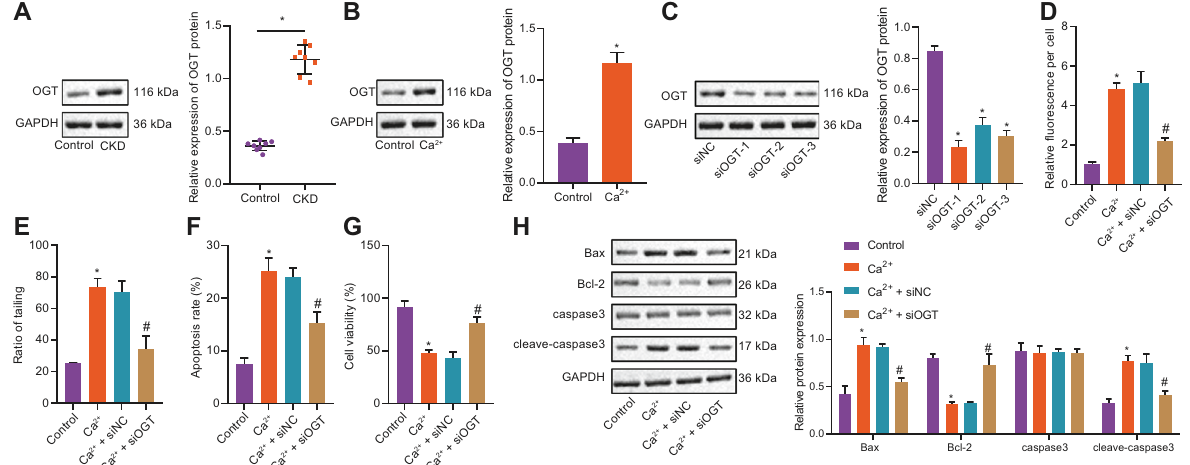
Fig. 2 Silencing OGT reduces the toxicity of primary neurons induced by hypercalcemia. A Western blot analysis was used to detect the expression of OGT in brain tissues of mice in each group (n = 8). * p < 0.05. vs . the control group (mice on a standard diet). B Expression of OGT in neurons induced by hypercalcemia. * p < 0.05. vs. the control group (neurons cultured in basic medium). C Western blot analysis was used to detect the interference ef fi ciency of three OGT interference sequences. * p < 0.05. vs. the si-NC group (neurons treated with si-NC). D luo-4-am, and Perkin Elmer Operetta were used to measure the intracellular calcium level. E Comet assay was used to observe the DNA damage of each group. F Flow cytometry was used to detect apoptosis. G MTS assay was used to detect the neuronal viability. H Western blot analysis was used to detect the expression of apoptosis-related proteins. * p < 0.05. vs. the control group (neurons cultured in basic medium). # p < 0.05. vs. the Ca 2 + + si-NC group (neurons treated with Ca 2 + + si-NC). The experiment was repeated 3 times independently. than that in the control group (Fig. 2A). After that, we primarily memory abilities of CKD mice were worse (Fig. 1E). Compared with cultured mouse neurons, and the neurons were induced to the control group, the content of calcium in brain tissues of CKD produce hypercalcemia by using a high calcium concentration mice was increased (Fig. 1F). TUNEL staining results showed that medium. The results showed that the expression of OGT in mouse compared with the control group, CKD mice had more neuronal apoptosis (Fig. 1G). The above results indicate that calcium content in brain tissues of CKD model mice is increased and nerve function is obviously damaged. OGT is highly expressed in kidney tissues of CKD model mice. Silencing OGT reduced the toxicity of primary neurons induced by hypercalcemia It has been con fi rmed that OGT is expressed in the kidney of CKD mice. Here, we further explore whether OGT can reduce hypercalcemia-induced neurotoxicity by silencing OGT. First of all, the expression of OGT in brain tissues of CKD mice was higher si-OGT-treated mice was decreased (Fig. 2E). Flow cytometric data